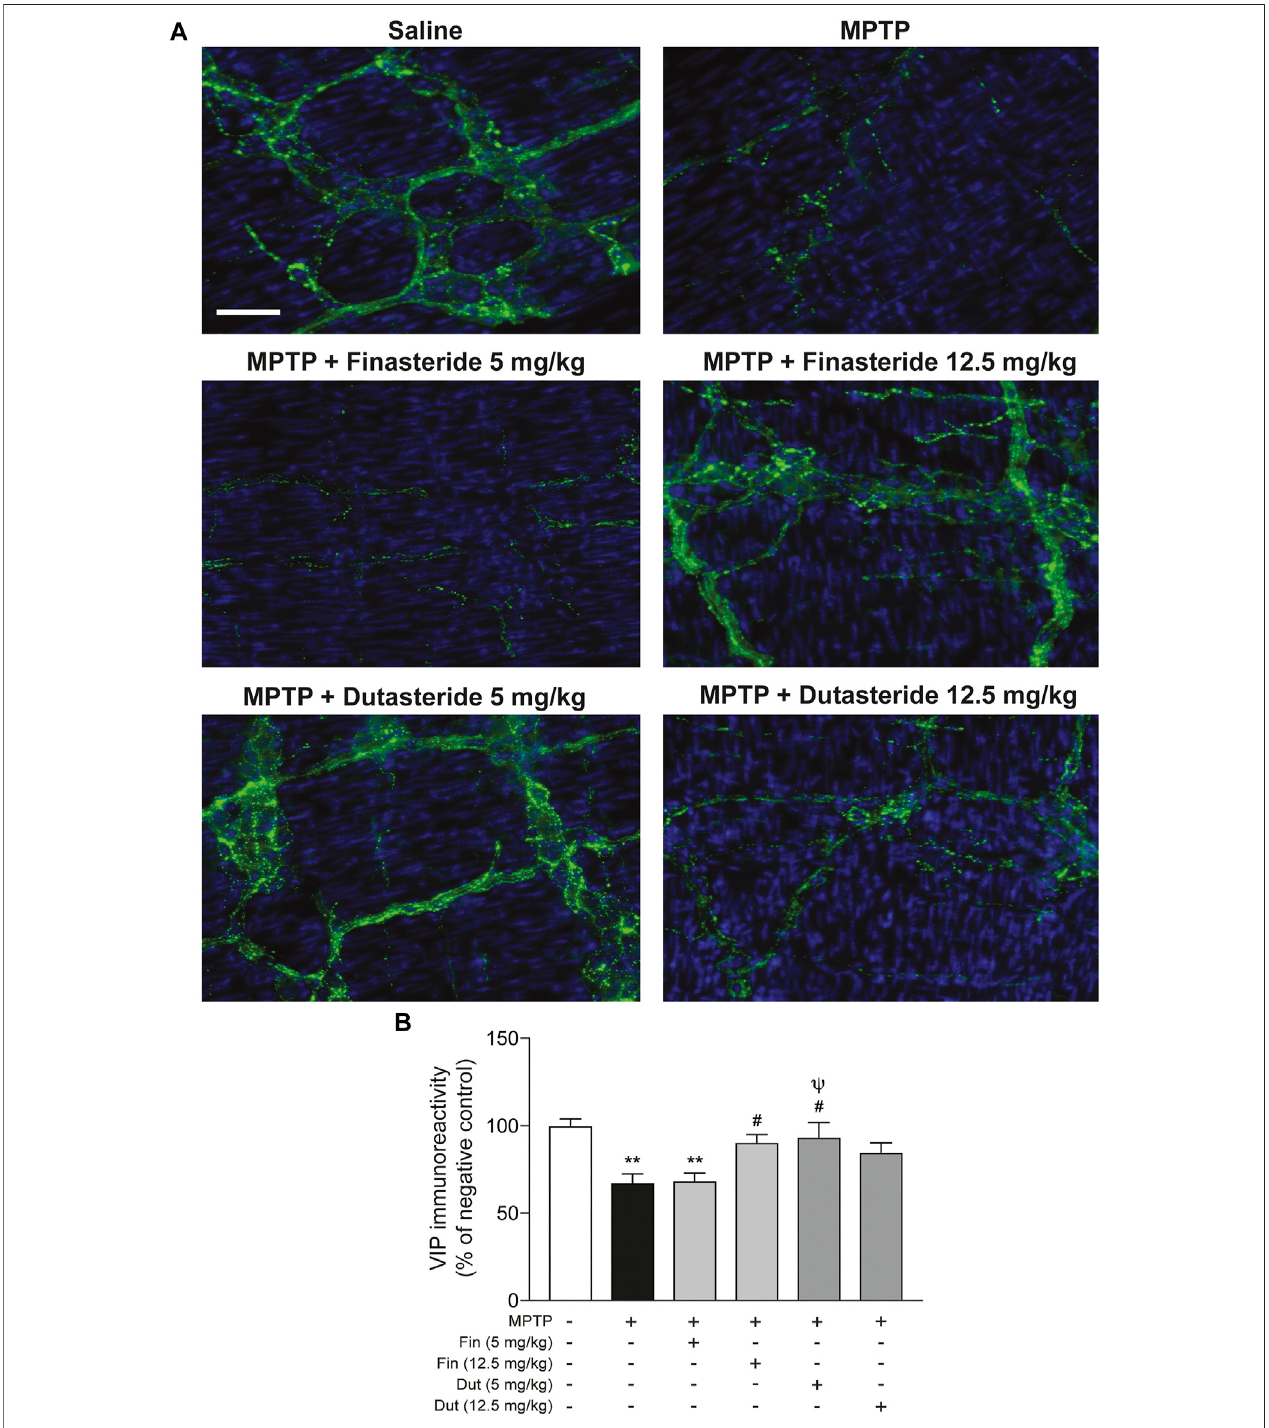
FIGURE 2 | Protection of VIP neurons in the myenteric plexus of MPTP mice with fi nasteride and dutasteride. (A) Photomicrographs of VIP immuno fl uorescence staining in the myenteric plexus of the distal ileum; scale bar = 25 µm. (B) VIP immunoreactivity showed neuroprotective effect of fi nasteride (Fin) (12.5 mg/kg) and dutasteride (Dut) (5 mg/kg) in MPTP mice. Values shown are the average densities (per mm 2 ) ± SEM of 8 – 10 mice per group. ** p < 0.01 compared to saline controls mice; # p < 0.05 compared to MPTP lesioned mice; ψ p < 0.05 compared to MPTP + fi nasteride (5 mg/kg) treated mice.